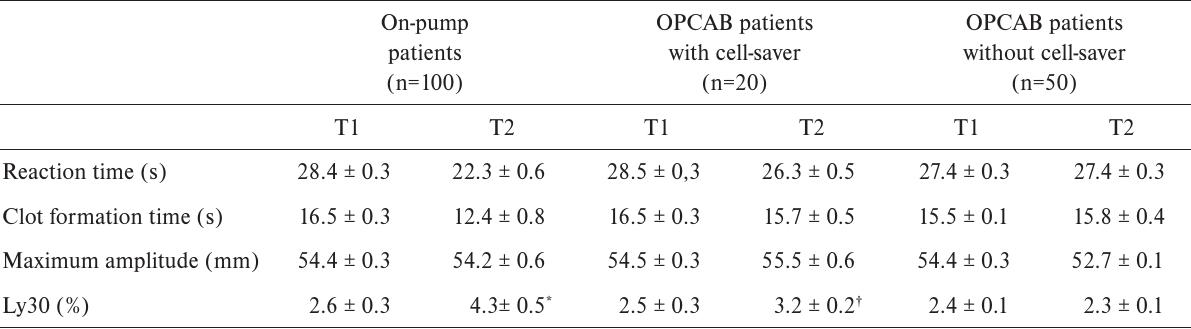
Table 1. Thromboelastographical values at the start of the operation (T1) and at the end (T2) in on-pump and off-pump pa- tients with/without